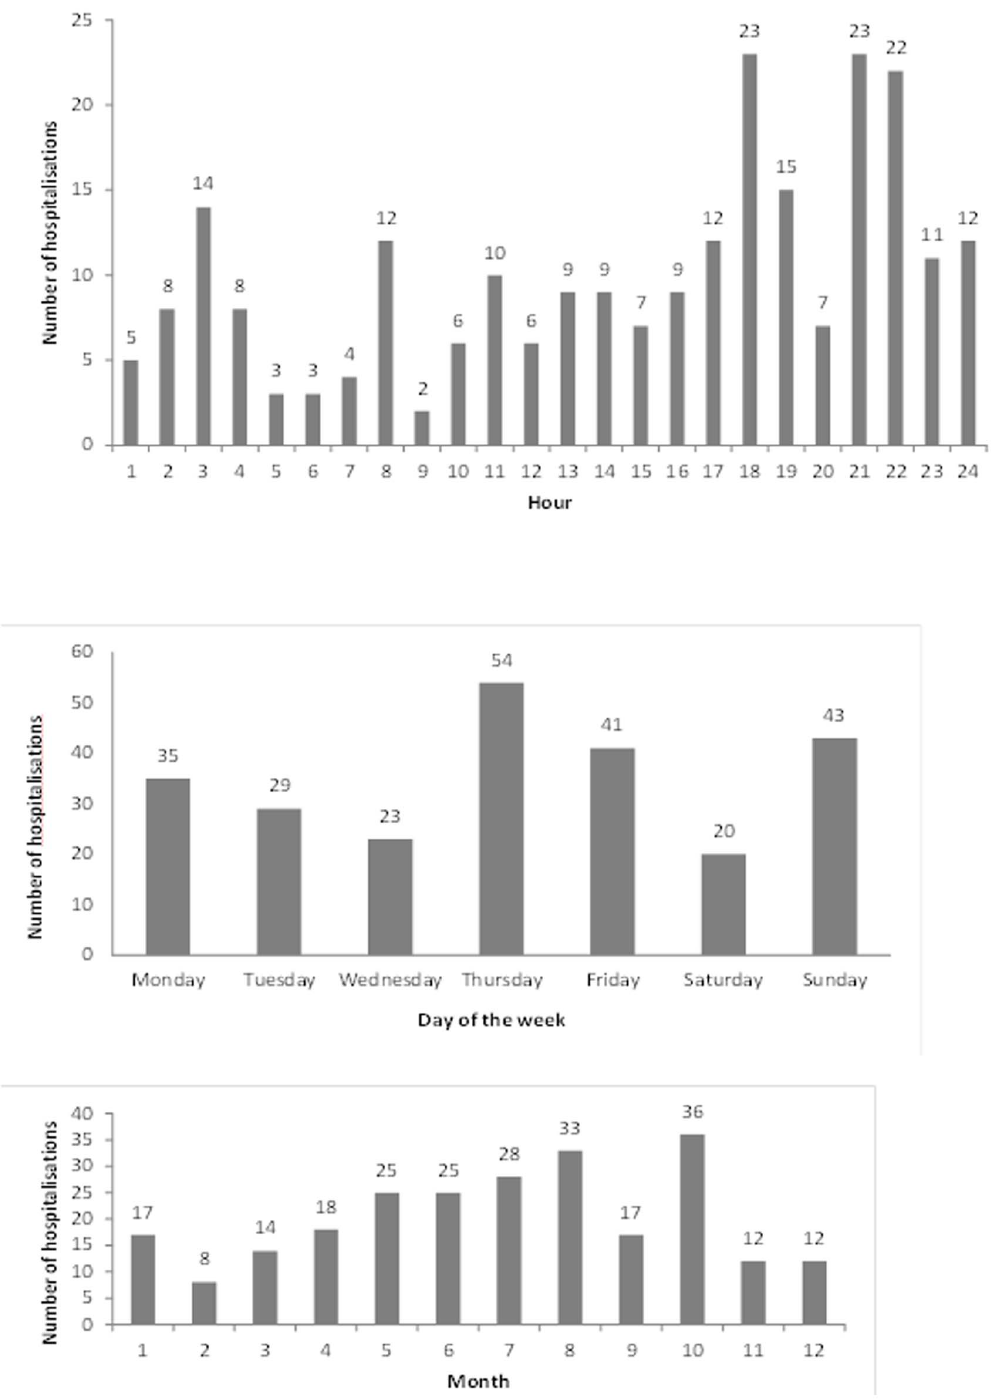
Figure 2. Traffic-related injury hospitalisations by time of collision (month, day and hour), Al Ain, 2006–2007 (n=245).